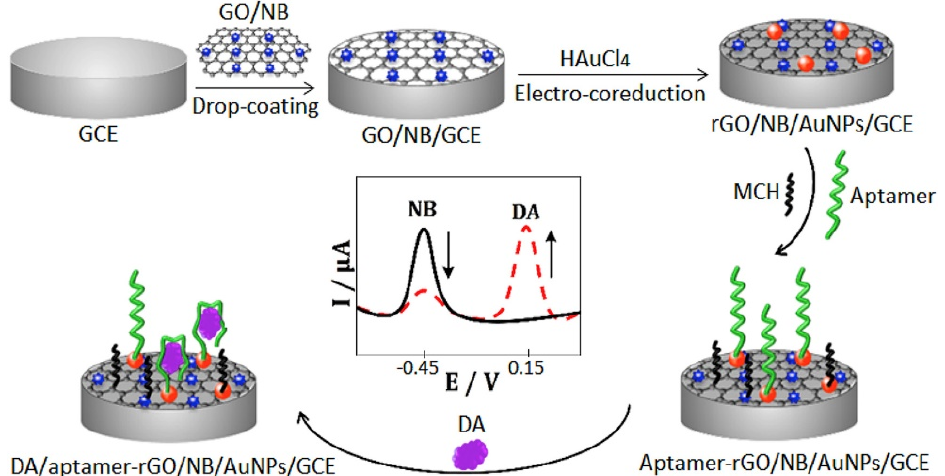
Figure 3. Scheme of the process of electrode surface coating with Nile blue (NB) graphene oxide (GO) gold nanoparticles (AuNPs) nanocomposite and for the construction of dopamine aptasensor. Adapted with permission from Jin et al. [61]. Copyright © (2018), Elsevier.